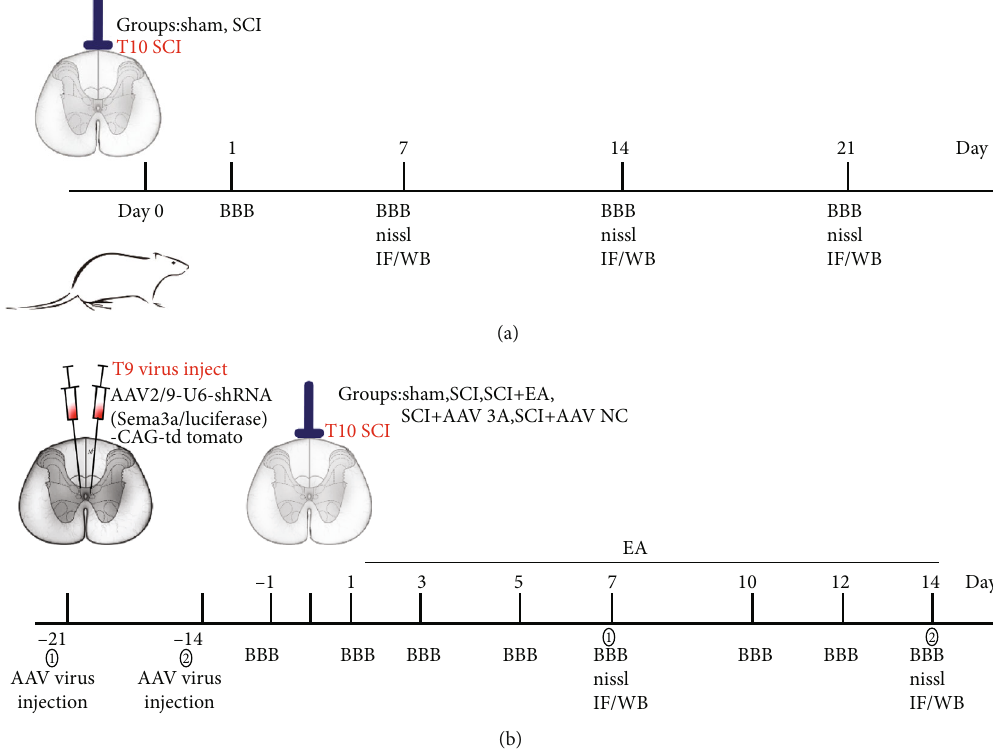
Figure 1: (a, b) Timeline of the experimental